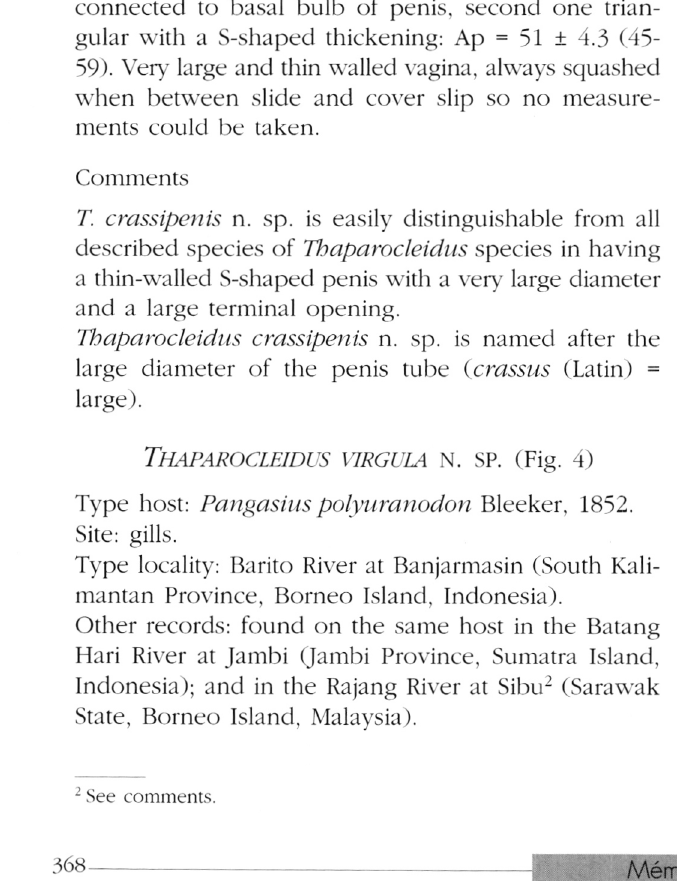
Fig. 4. - Thaparocleidus virgula n. sp. C = cuneus; DB = dorsal trans­ verse bar; DG = dorsal gripus; MA = male apparatus; VB - ventral transverse bar; VG = ventral gripus; V = vagina; U = uncinulus. Bar = 30 µm.